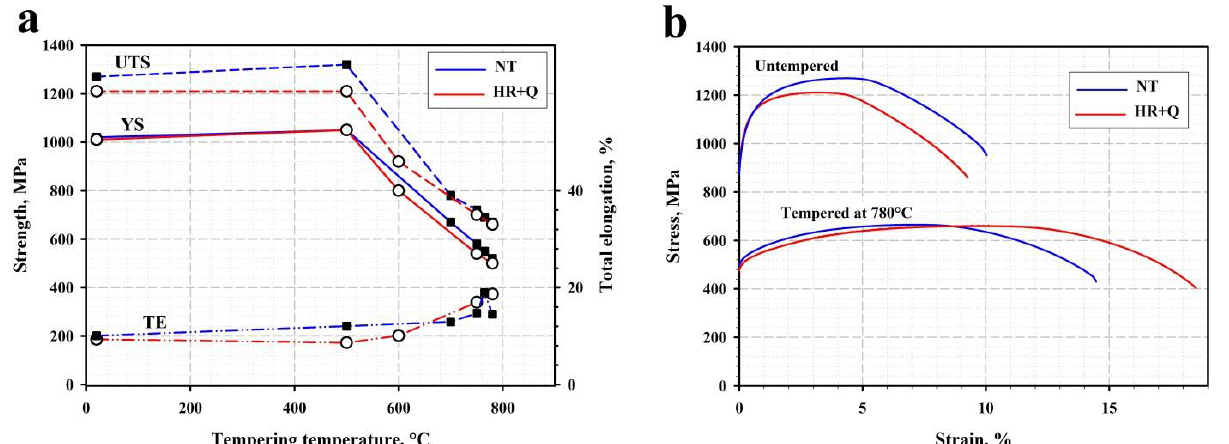
Figure 2. The effect of tempering temperature on the tensile properties of the NT and HR+Q samples ( a ) and the engineering stress–strain curves of the NT and HR+Q samples ( b ).